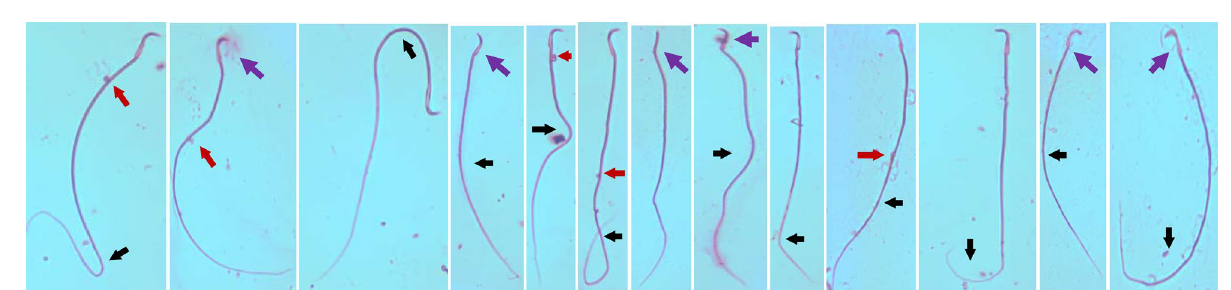
Figure 4. Different sperm defects observed in head and tail. The defects in the head are shown by a purple arrow ( ), and the tail defects are shown by a black arrow ( ). Red-colored arrows ( ) show cytoplasmic residues.